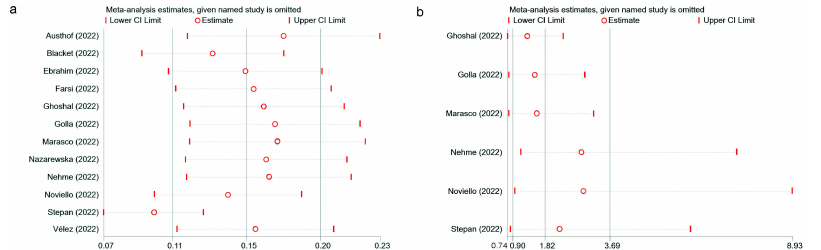
Figure 7. Sensitivity analysis. The IBS prevalence after SARS-CoV-2 infection ( a ) [19–24,33–38] and the association between IBS and SARS-CoV-2 infection ( b ) [22,23,34–36,38].